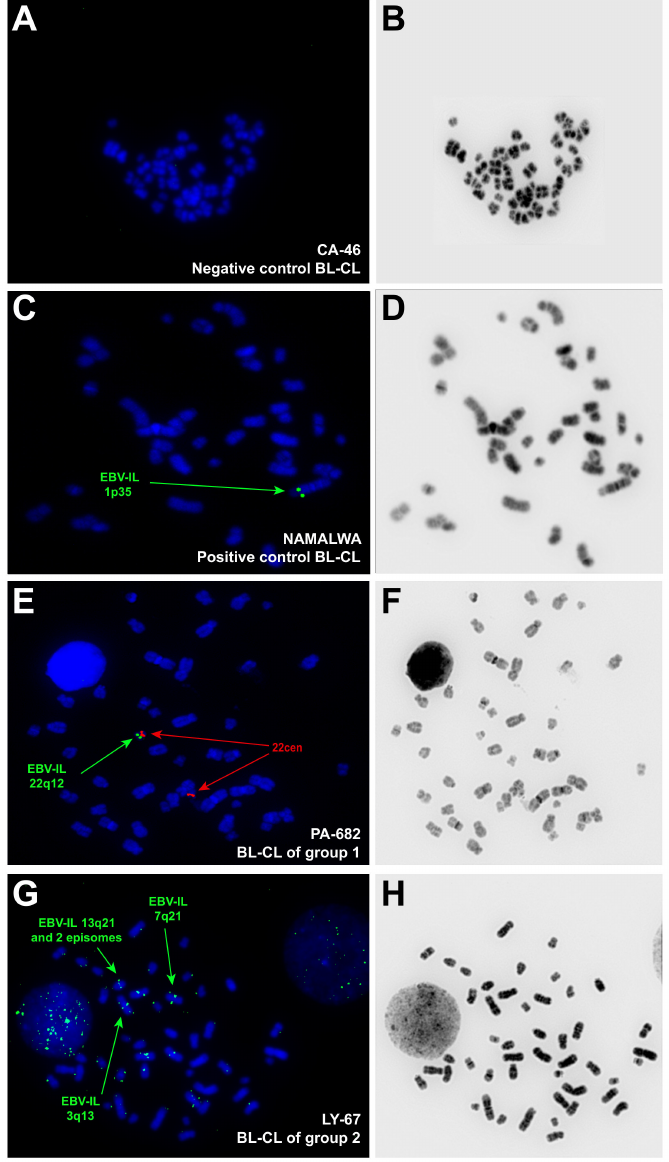
Figure 1. Representative images of EBV-IS using FISH on metaphases of BL-CL. The presence of symmetrical doublet hybridization signals at the same chromosomal loci of both sister chromatids represents the integration of EBV in the host genome, whereas single weak hybridization signals represent episomal viral locations. The inverted DAPI-counterstaining used for chromosomes assign- ment is also displayed ( B , D , F , H ). ( A , B ) EBV-negative BL-CL CA-46 was used as a negative control and showed, as expected, no hybridization signals of the EBV probe. ( C , D ) One EBV-IS located on 1p35, green hybridization signals highlighted with a green arrow, was visualized in the BL-CL Namalwa (group 1). ( E , F ) A unique EBV-IS on cytoband 22q12 was identified in PA-682 (group 1), green hybridization signals highlighted with a green arrow. A centromere probe for chromosome 22, red signals highlighted with a red arrow, was co-hybridized to confirm the localization of the integration of EBV on chromosome 22. ( G , H ) In BL-CL LY-67 (group 2) highly recurrent EBV-IL on 7q21 and 13q21, and non-recurrent IL on 3q13 is highlighted with green